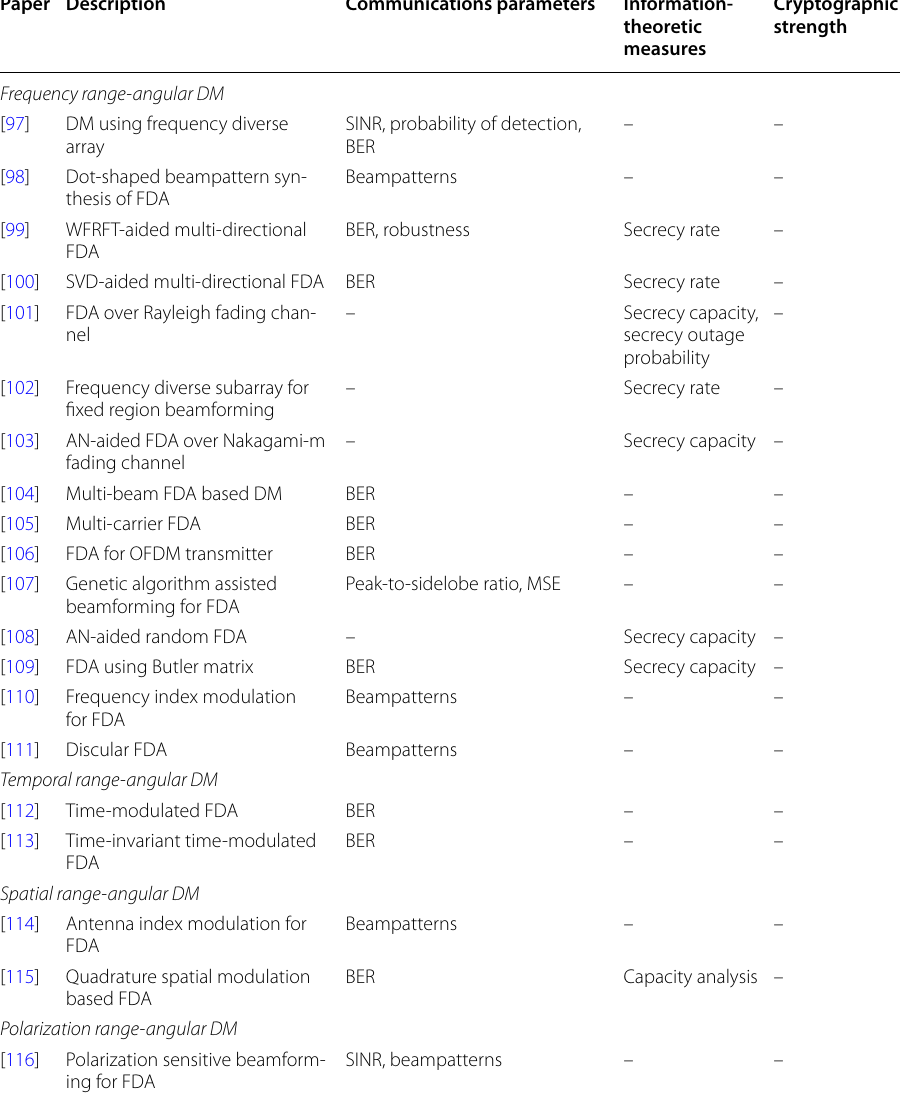
Table 5 Secure communication using range-angular DM techniques Paper